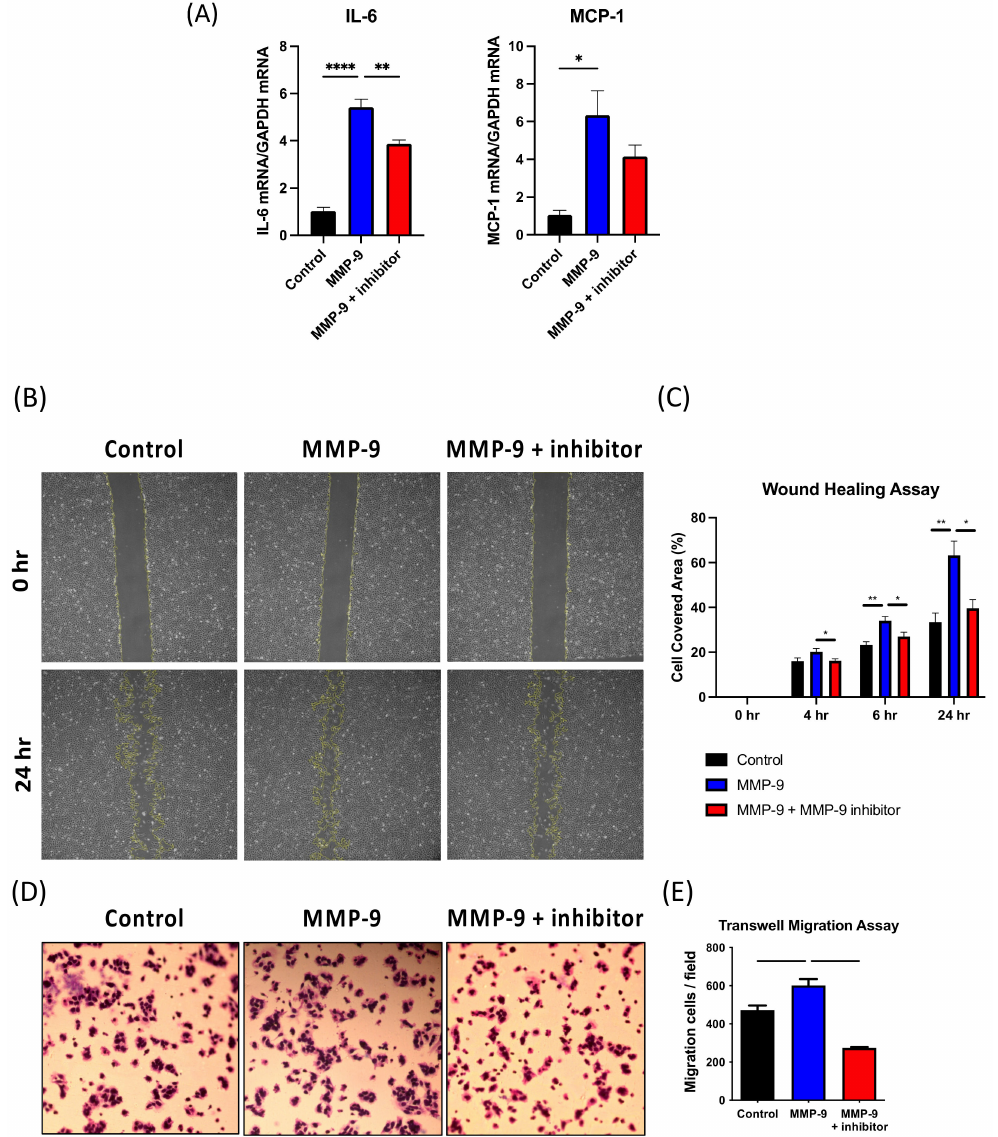
Figure 8. Mouse vascular smooth muscle cell line (MOVAS) was used for in vitro study. ( A ) MCP-1 and IL-6 mRNA expression was assessed by qPCR. The influence of matrix metalloproteinase 9 (MMP-9) on MOVAS migration was assessed using ( B , C ) wound healing and ( D , E ) transwell migration assays. * p < 0.05, ** p < 0.01, *** p < 0.001, **** p < 0.0001. Data presented as mean ± SEM. Data analyzed by one-way analysis of variance (ANOVA) followed by Bonferroni post hoc analysis, n = 6 in each